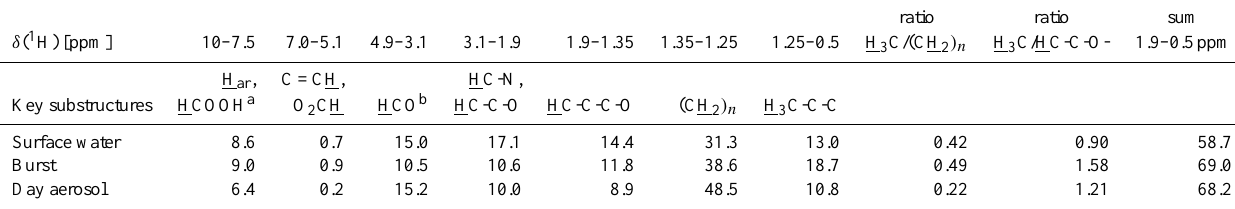
ratio ratio sum